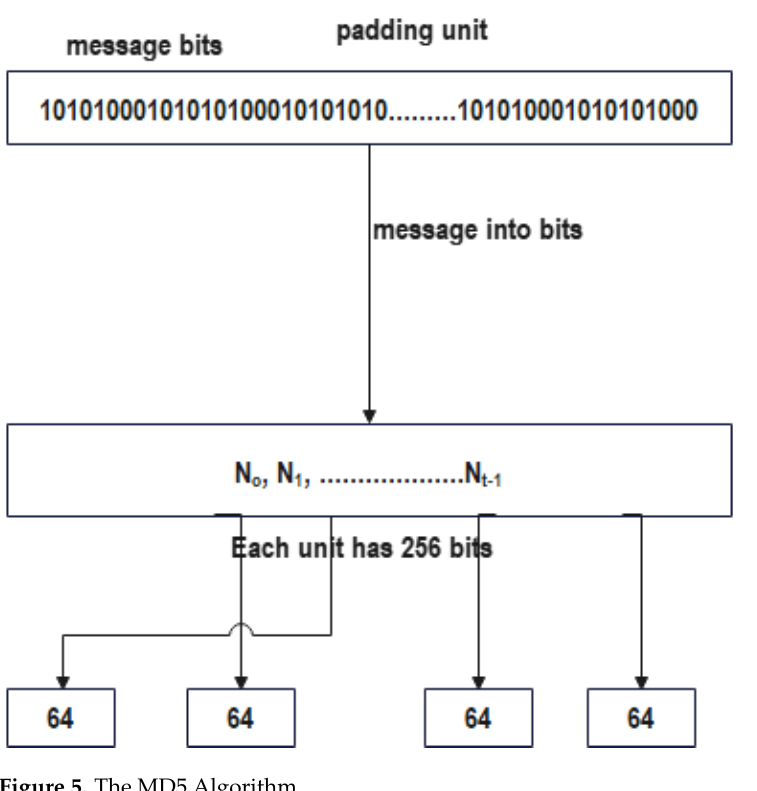
Figure 5. The MD5